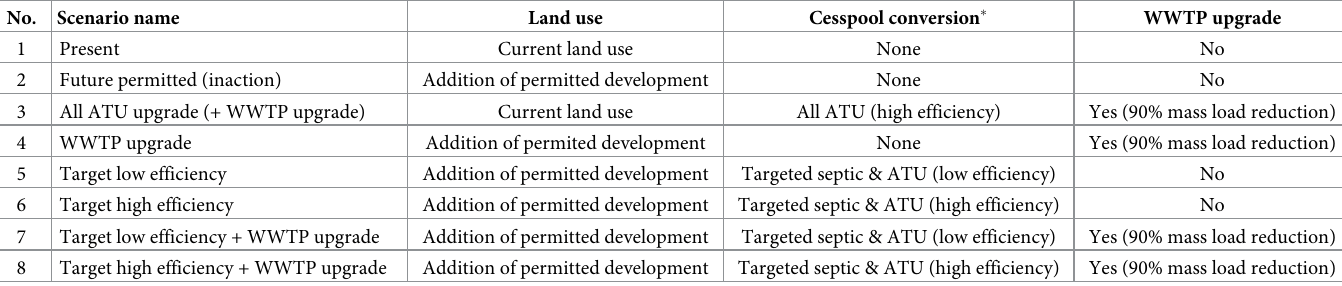
Table 1. Description of wastewater management